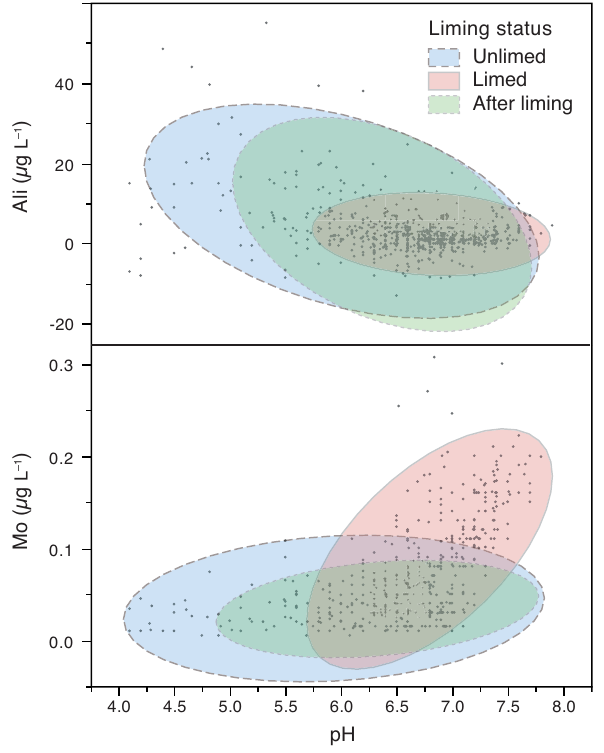
Fig. 8. The influence of pH on inorganic aluminium (Ali, upper panel) and molybdenum (lower panel) concentrations in stream wa- ter. The bivariate normal density ellipses (90%) illustrate the sign and strength of the correlation under unlimed conditions (blue ar- eas), limed conditions (red areas) and after that liming was termi- nated in 1995 (green areas).